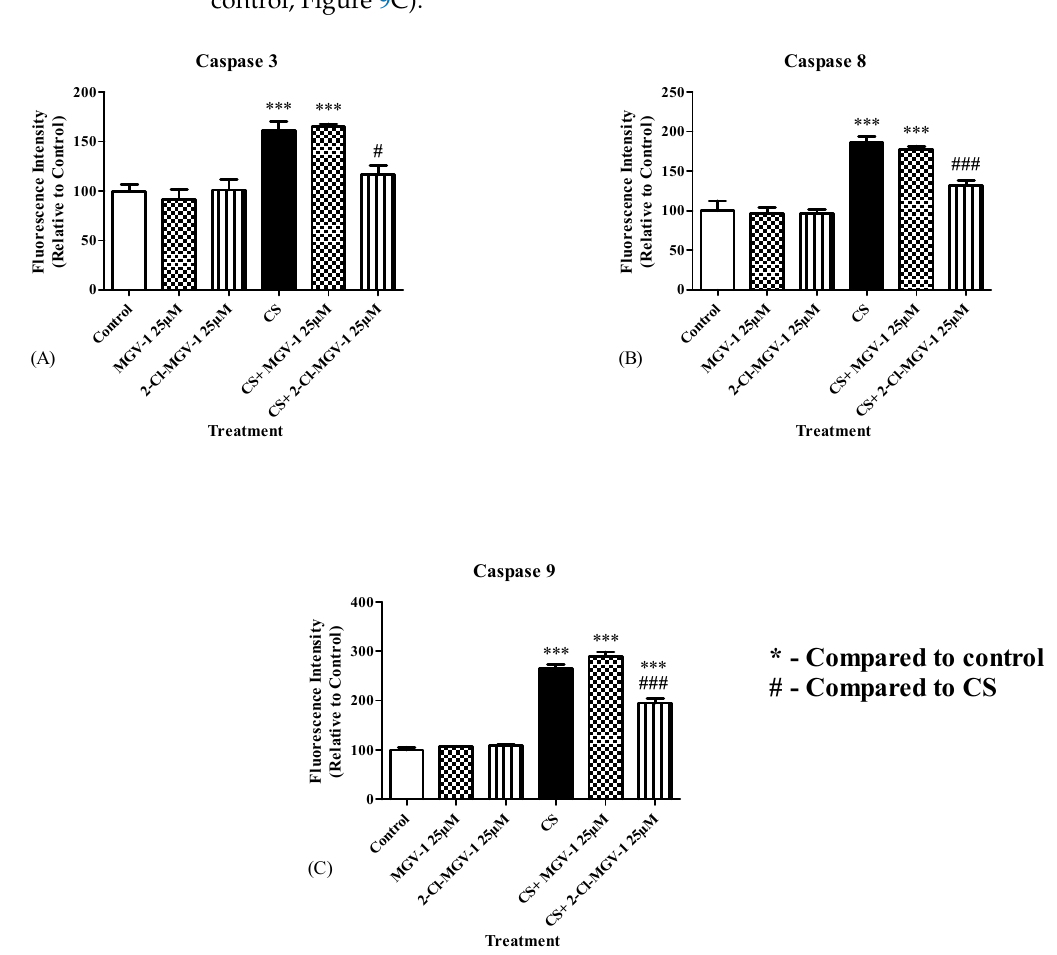
Figure 9. The impact of TSPO ligands on CS-induced increases in caspases 3, 8 and 9 in H1299 lung cancer cells. Caspase multiplex activity assay was used to measure the levels caspase 3 ( A ), 8 ( B ) and 9 ( C ) following CS exposure with or without TSPO ligands. The control, MGV-1 and 2-Cl-MGV-1 groups were exposed to fresh air only. The apoptotic markers, caspases 3, 8 and 9, significantly elevated following CS exposure. Pretreatment with MGV-1 and 2-Cl-MGV-1 attenuated the elevation in the caspases’ levels at various levels. Results are represented as mean ± SEM ( n = 5 in each group). # p < 0.05 and ### p < 0.001 vs. CS, *** p < 0.001 vs. control. CS = cigarette smoke.